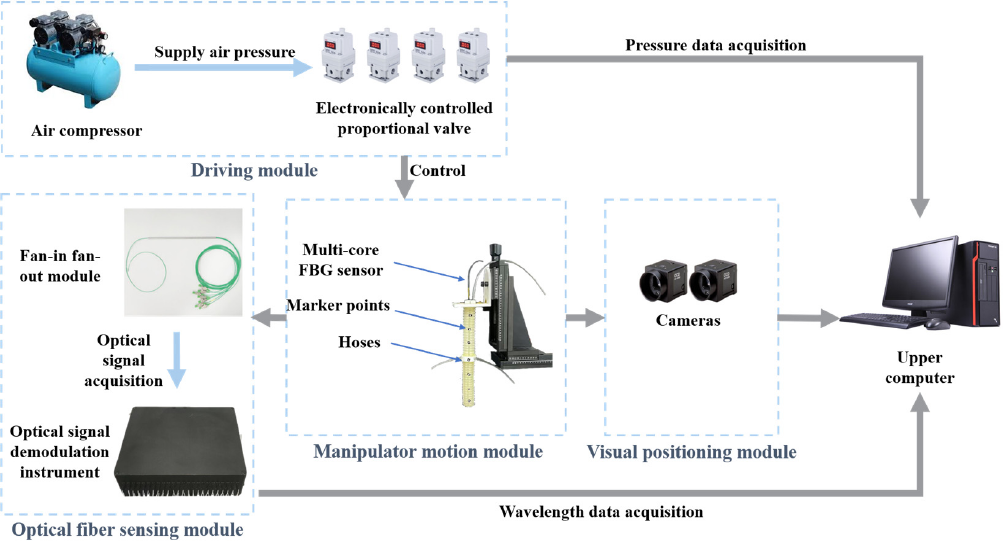
Figure 6. Experiment